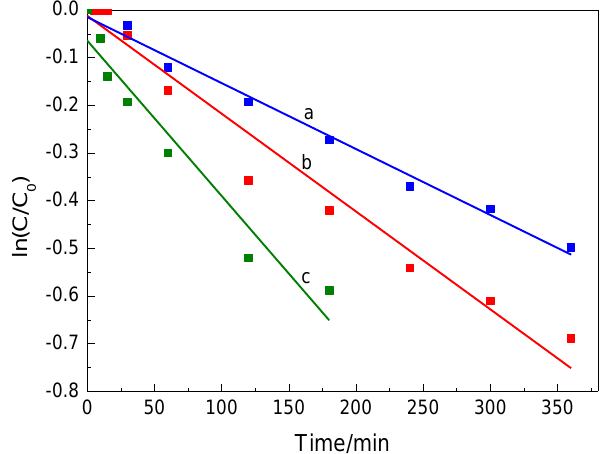
Figure 5. First-order kinetic fitting curves of RhB photodegradation under UV light irradiation using different photocatalysts: BTO_1 ( a ), BTO_2 ( b ), and BTO_3 ( c ). As shown in Figures 4 and 5, the reaction rate of BTO_3 (k = 3.3 × 10 − 3 min − 1 ) was about 10 times that of BTO (k = 3.0 × 10 − 4 min − 1 ), 2 times that of BTO_1 (k = 1.4 × 10 − 3 min − 1 ), and 1.5 times that of BTO_2 (k = 1.9 × 10 − 3 min − 1 ), respectively. Obviously, BTO_3 pre- sented a much higher photocatalytic efficiency than pure BTO or BTO with (co)catalysts loaded with lower MnO 2 quantities. This might be due to the fact that MnO 2 promotes the migration of holes and, therefore, more charge carriers could participate in the reaction. The changes in the absorption spectra of RhB dye solutions during irradiation showed a shift towards lower wavelengths of the absorption maximum of the peak at 554 nm when all the BTO modified with MnO 2 photocatalysts were employed. This hypsochromic